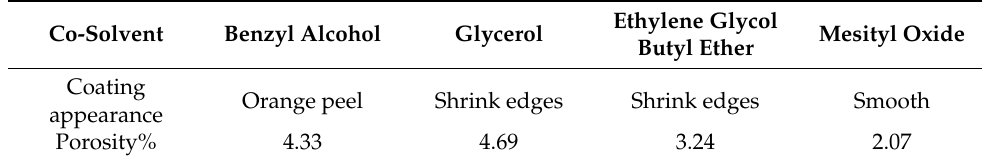
Table 5. Effects of the auxiliary solvent on the performance of the coating.